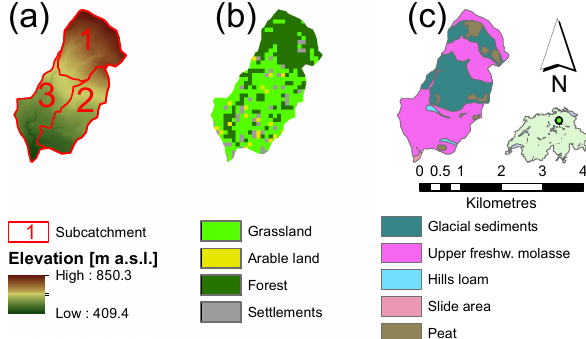
Figure 1. Overview of the Meilen catchment, Switzerland. (a) Digital terrain model (25m resolution) subdivided into three sub- catchments; (b) land-use map (100m resolution); (c) geology map (data: BFS GEOSTAT/Federal Office of Topography